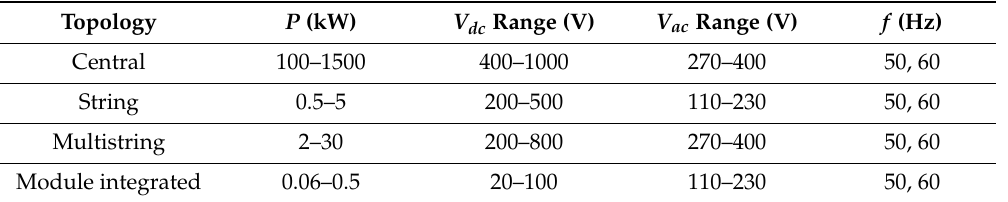
Table 1. Numerical information of PV inverter